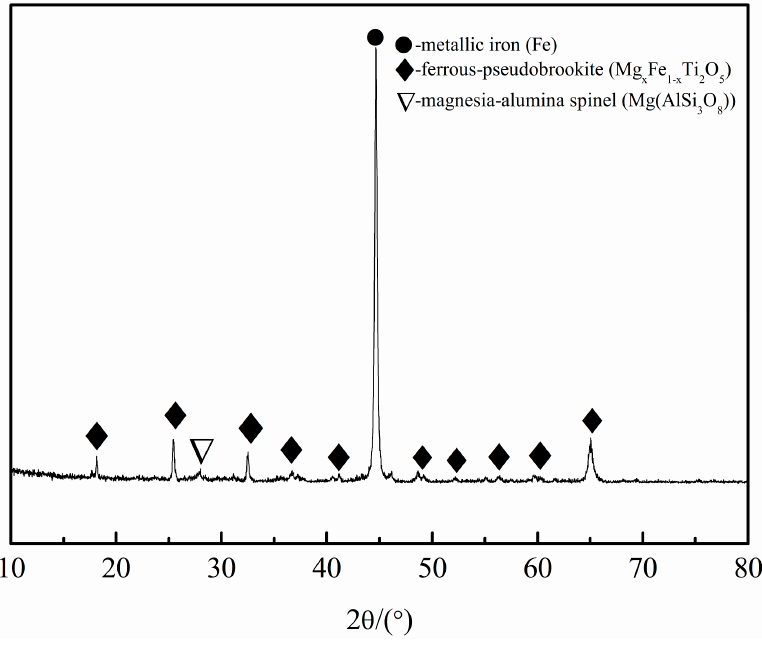
Figure 1. XRD pattern of metallized pellet.